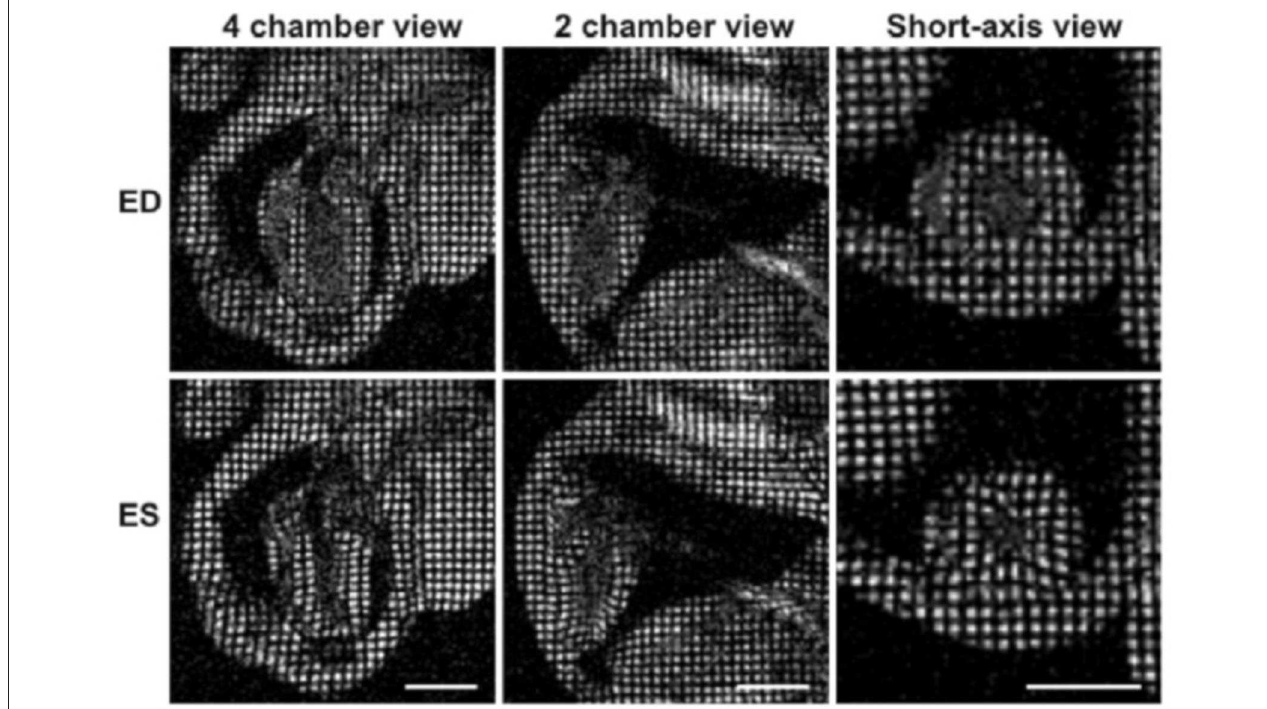
FIGURE 4 | Myocardial tagging in the mouse. Four-chamber, two-chamber, and short-axis views of a mouse heart at the end-diastole are shown in the top row, and the end-systolic frames are depicted in the lower row. The movement of the tagged myocardial tissue can be tracked to calculate myocardial strain. Reproduced with permission from Price [